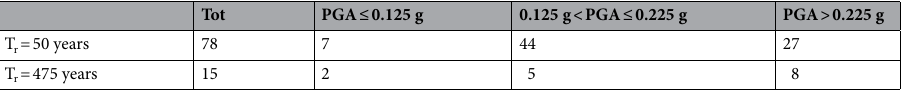
Table 1. Earthquakes causing exceedance area larger than zero, according to ShakeMap, divided per hazard level, based on the PGA on rock with 475 years exceedance return period at the epicenter.